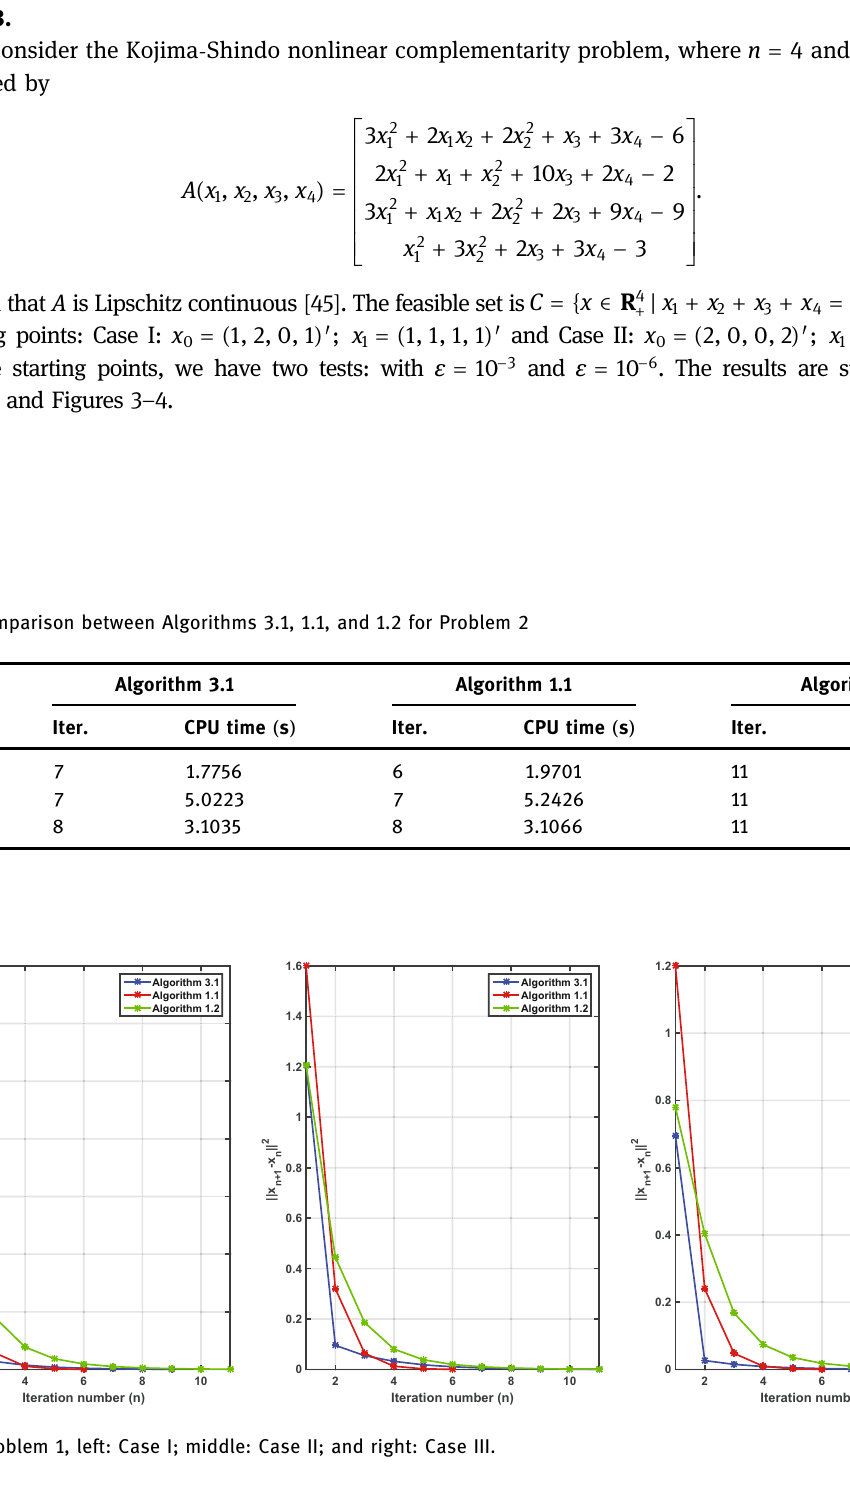
Figure 2: Problem 1, left: Case I; middle: Case II; and right: Case